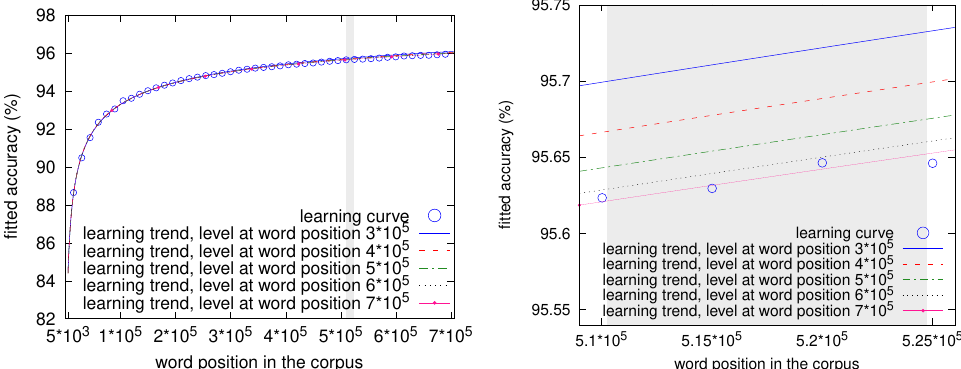
Figure 2. Learning trace for SVMT ool on X iada, with details in